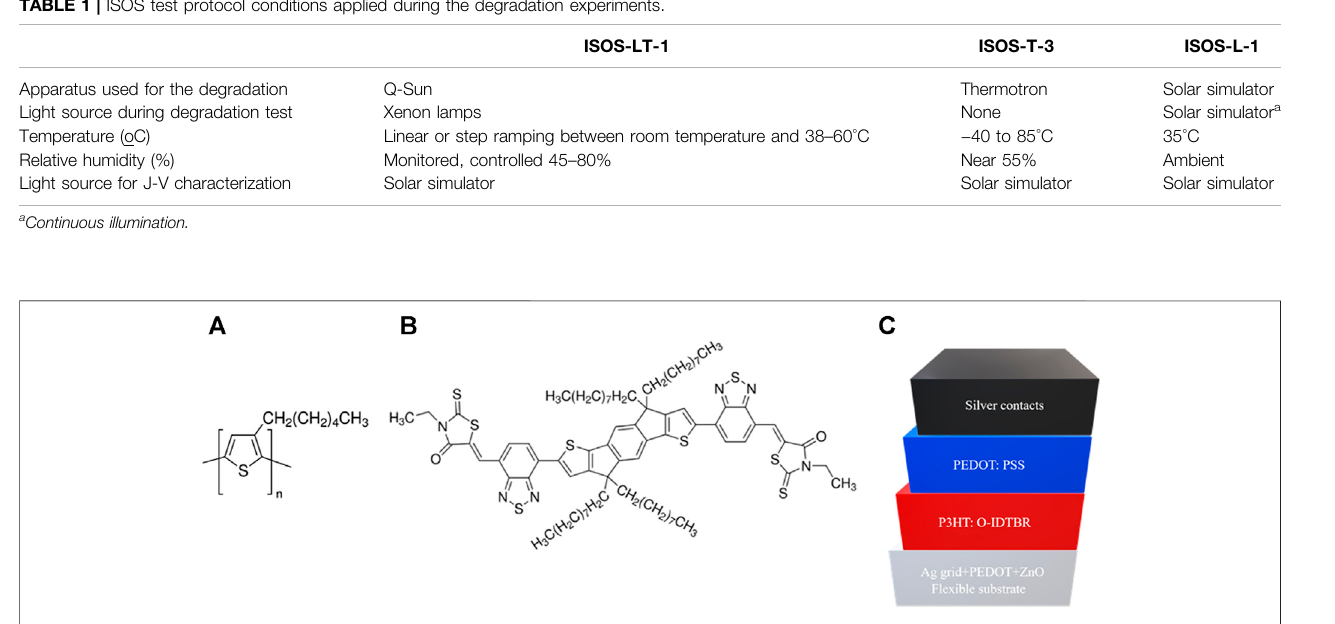
FIGURE 1 | The molecular structure of the components of the active layers: (A) P3HT acting as the donor, (B) in combination with the non – fullerene acceptor O-IDTBR. (C) The schematic structure of the ITO-free solar cells.